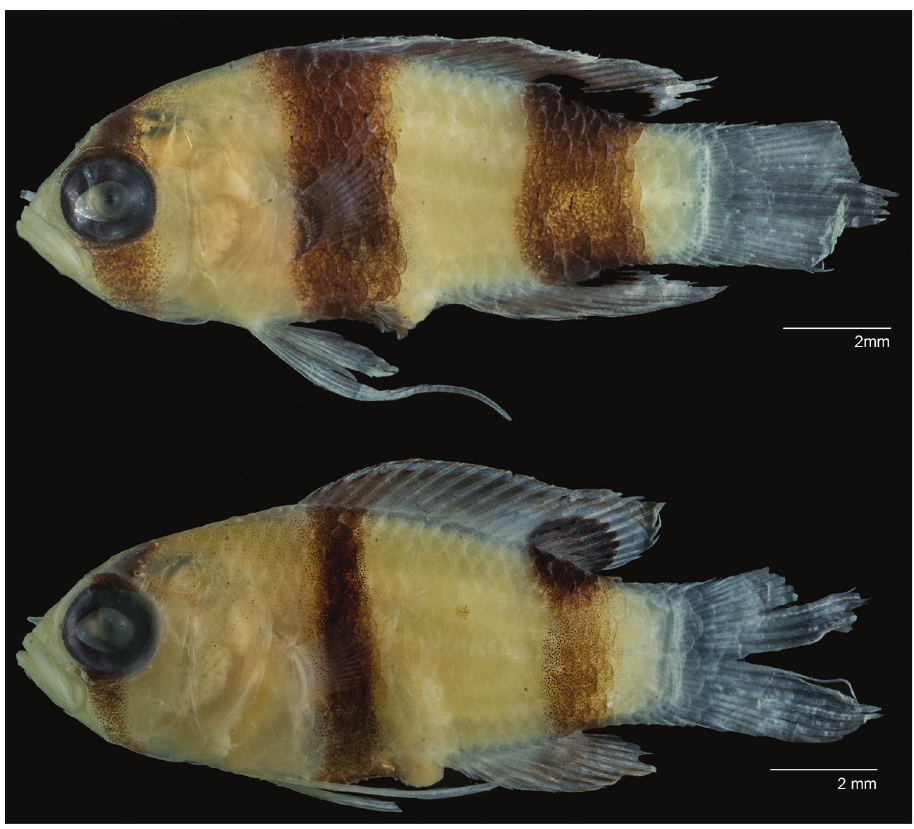
Figure 6. Comparison of juveniles of A Lipogramma levinsoni sp. n., USNM 440230, paratype, 13.4 mm SL and B L. evides , USNM 431410, 12.7 mm